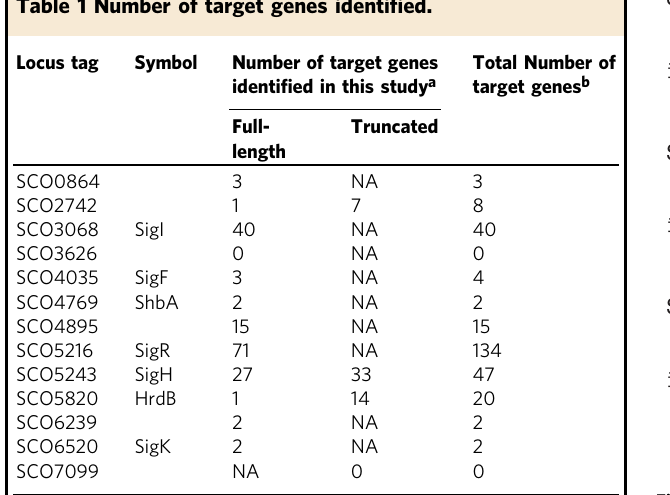
Fig. 2 Sigma factor recognition motifs. Sequence logos of the consensus sequences of the promoters recognised by SigH_ Δ N, SigI and SigR. The logo is an illustration of the position weight matrix of the promoter sequence